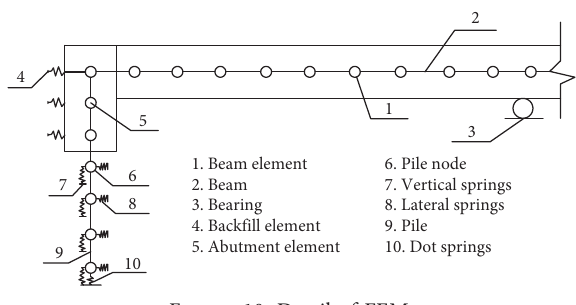
Figure 10: Detail of FEM.